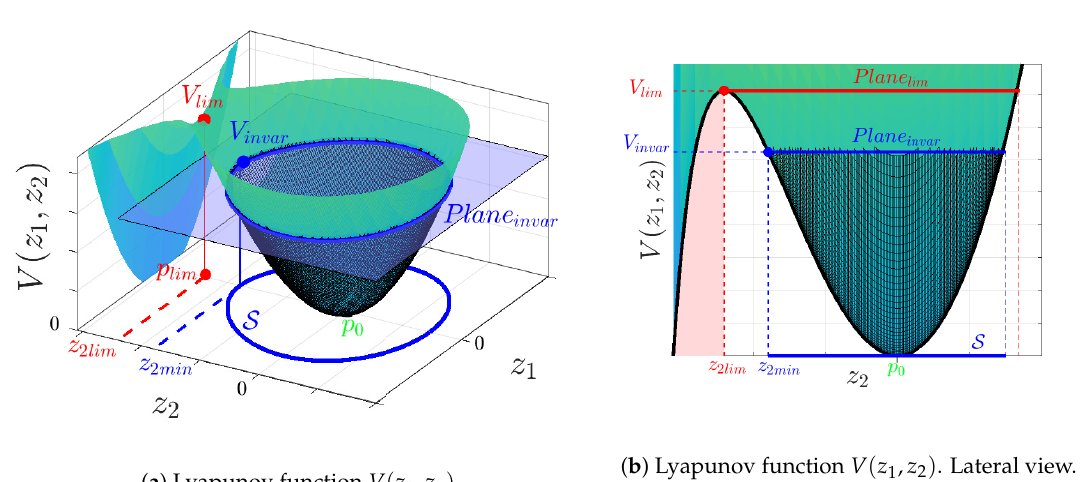
Figure 6. Illustration of the invariant region obtained through Lyapunov stability